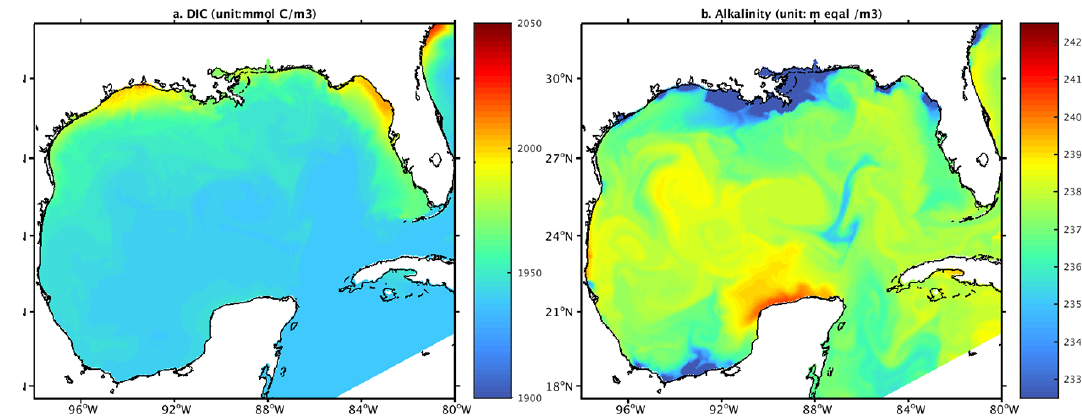
Figure 2. DIC and alkalinity initial conditions derived from the empirical relationship by Lee et al. (2000, 2006).